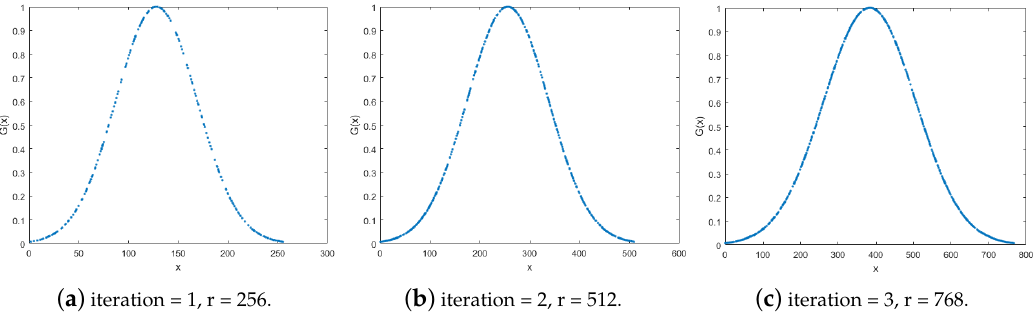
Figure 5. The 1-D Gaussian distribution following the the extending histogram